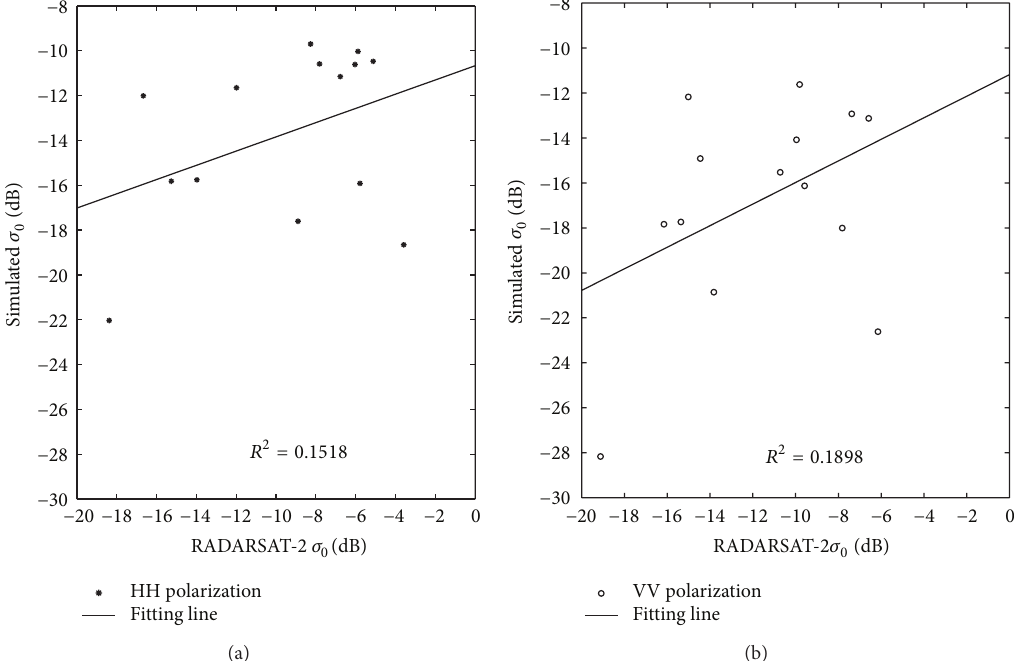
Figure 10: Simulated backscattering coefficient compared to the RADARSAT-2 images of the 16 ground samples, with HH polarization on (a) and VV polarization on